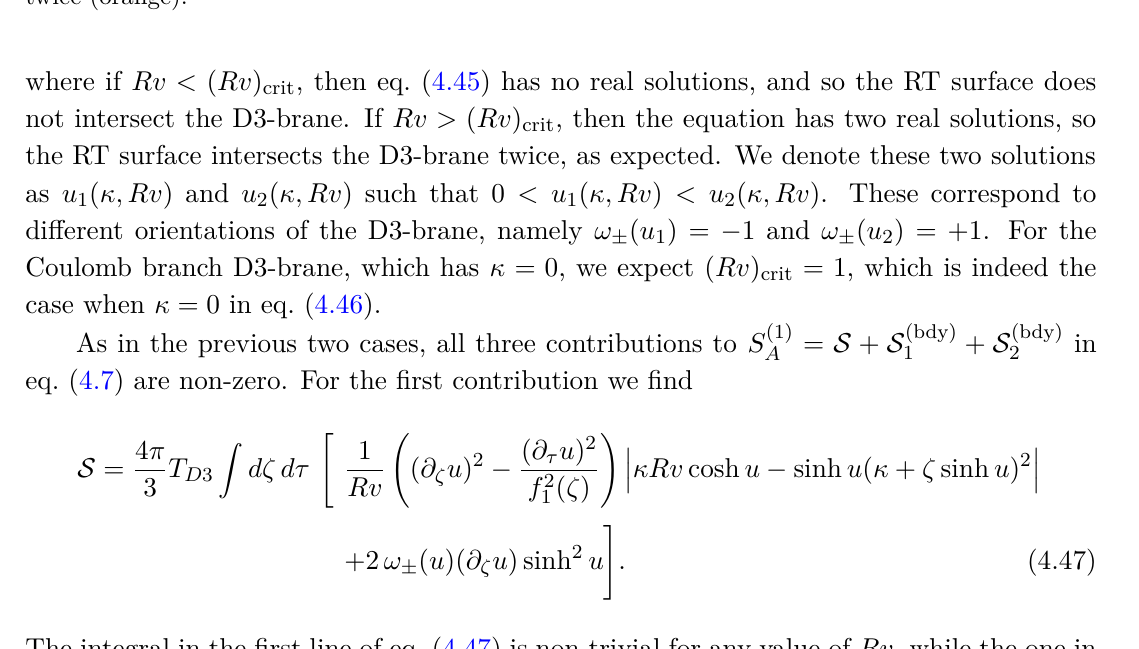
Figure 5 . Cross sections of RT surfaces of increasing Rv (purple, red, orange) and of the D3-brane embedding (green) for κ = 0 . 5 . When Rv < ( Rv ) crit , with ( Rv ) crit in eq. (4.46), the two do not intersect (purple). When Rv = ( Rv ) crit , they are tangent (red). When Rv > ( Rv ) crit , they intersect twice